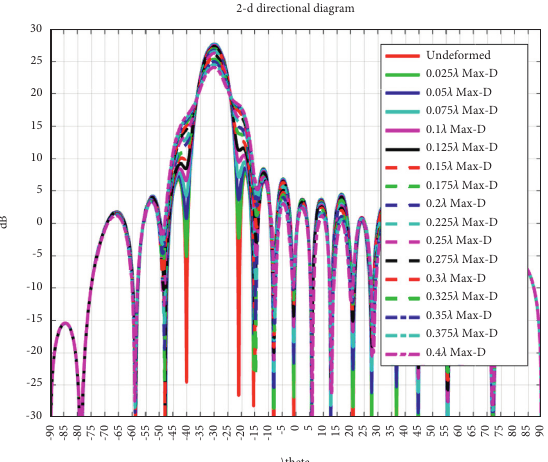
Figure 22: Saddle-shaped deformation azimuth scanning − 30 ° direction map.